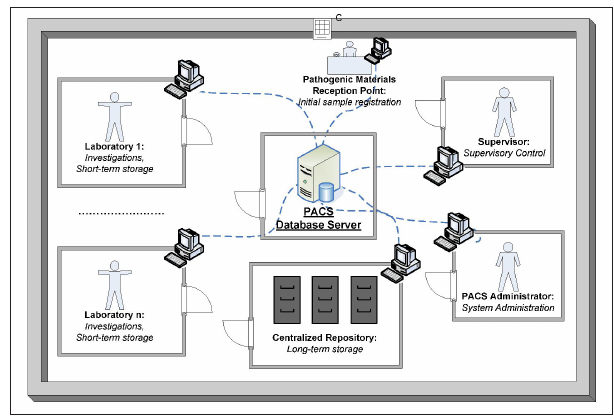
FIGURE 3: Pathogen Asset Control System conceptual schema.